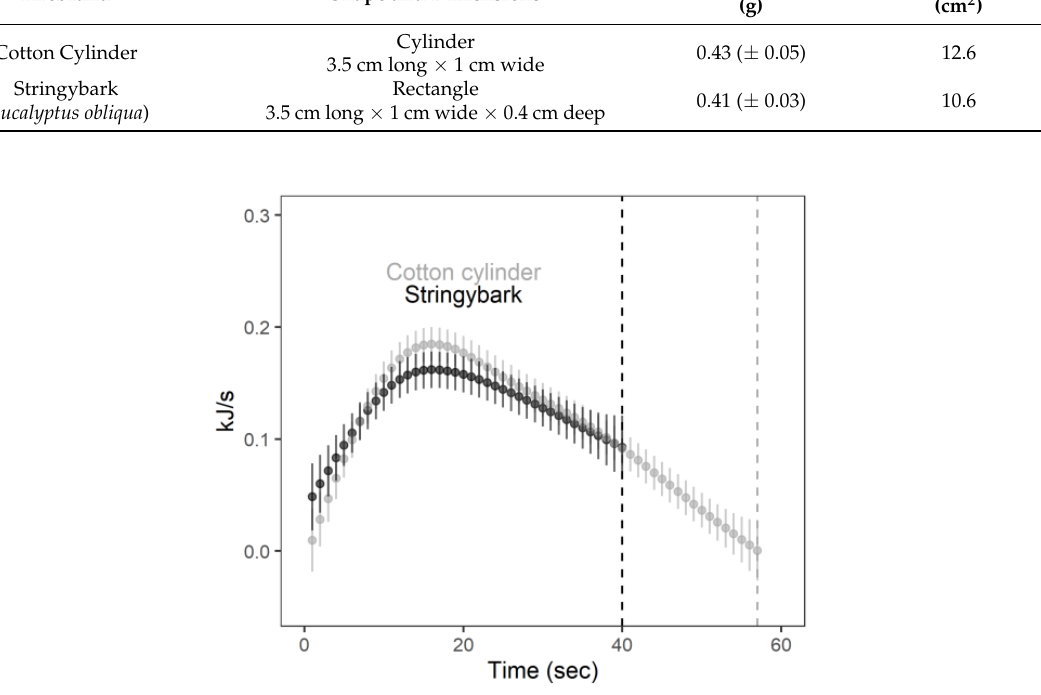
Figure A3. Mean heat release rate of stringybark (black) and cotton cylinder (grey). Dashed lines represent the mean flaming duration (stringybark = 40 s; cotton = 57 s). Error bars represent ± 1 standard error.